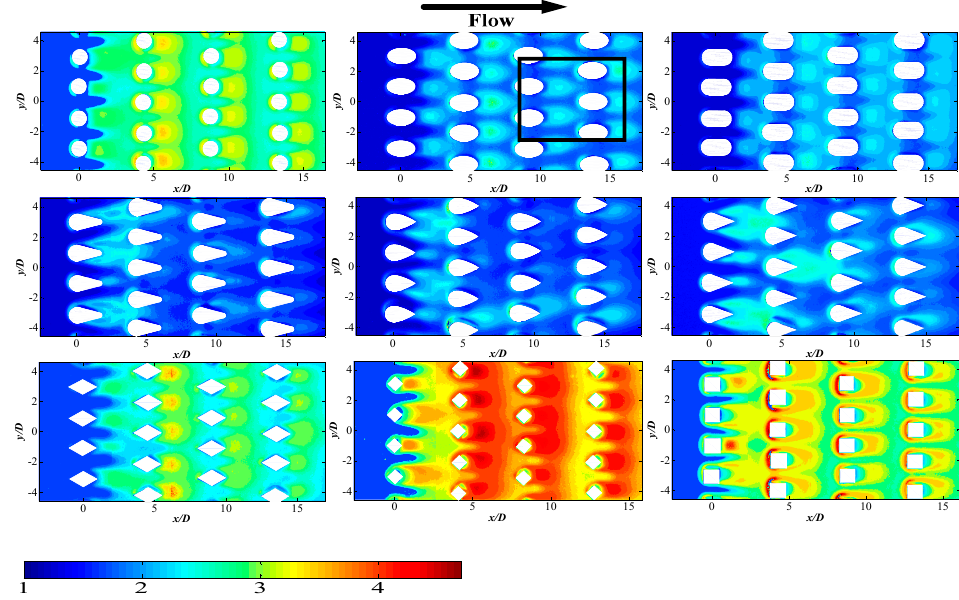
Figure 9. Local distribution of Nu / Nu 0 on endwall with nine different pin fins, Re = 50,000.